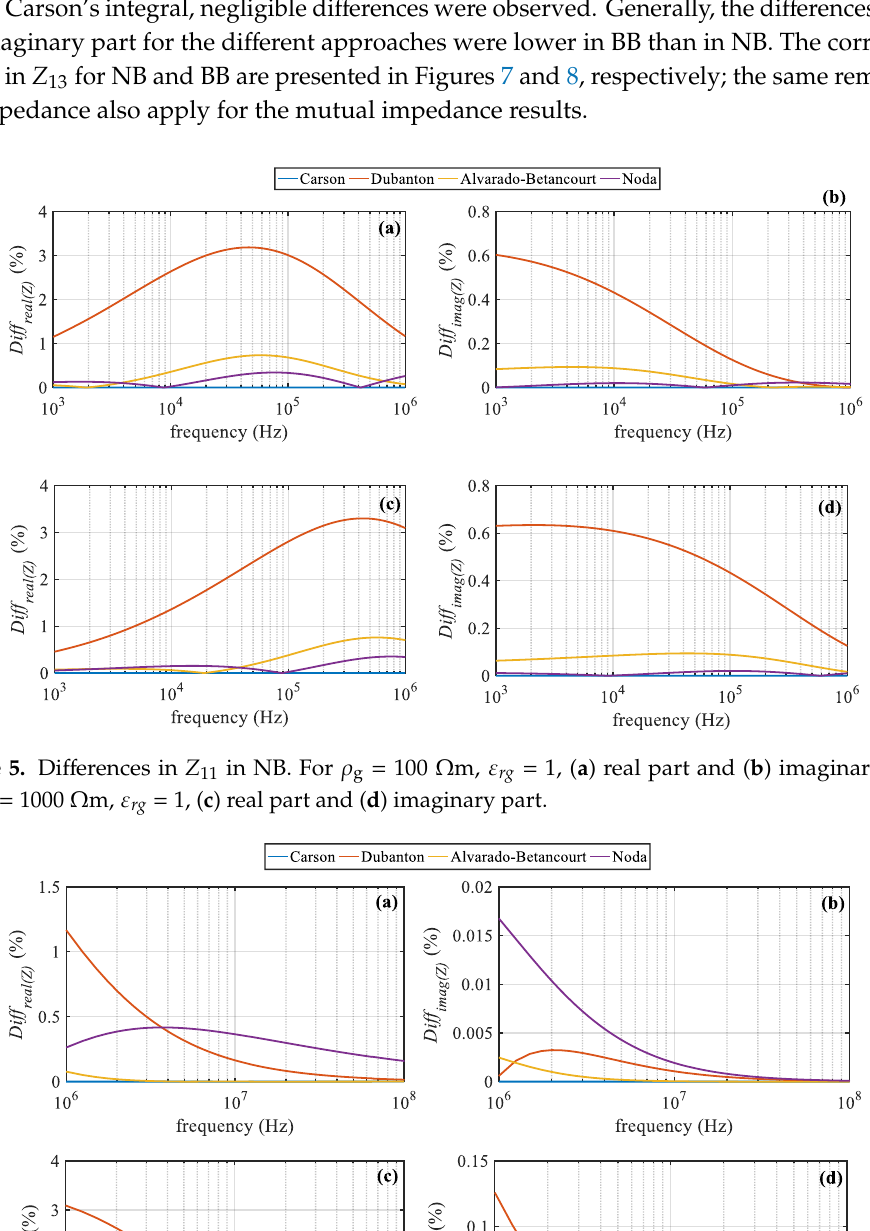
Figure 7. Differences in Z 13 in NB. F or ρ g = 100 Ωm, ε rg = 1 and ( a ) real part, ( b ) imaginary part, for ρ g = 1000 Ωm, ε rg = 1 and ( c ) real part, ( d ) imaginary part.